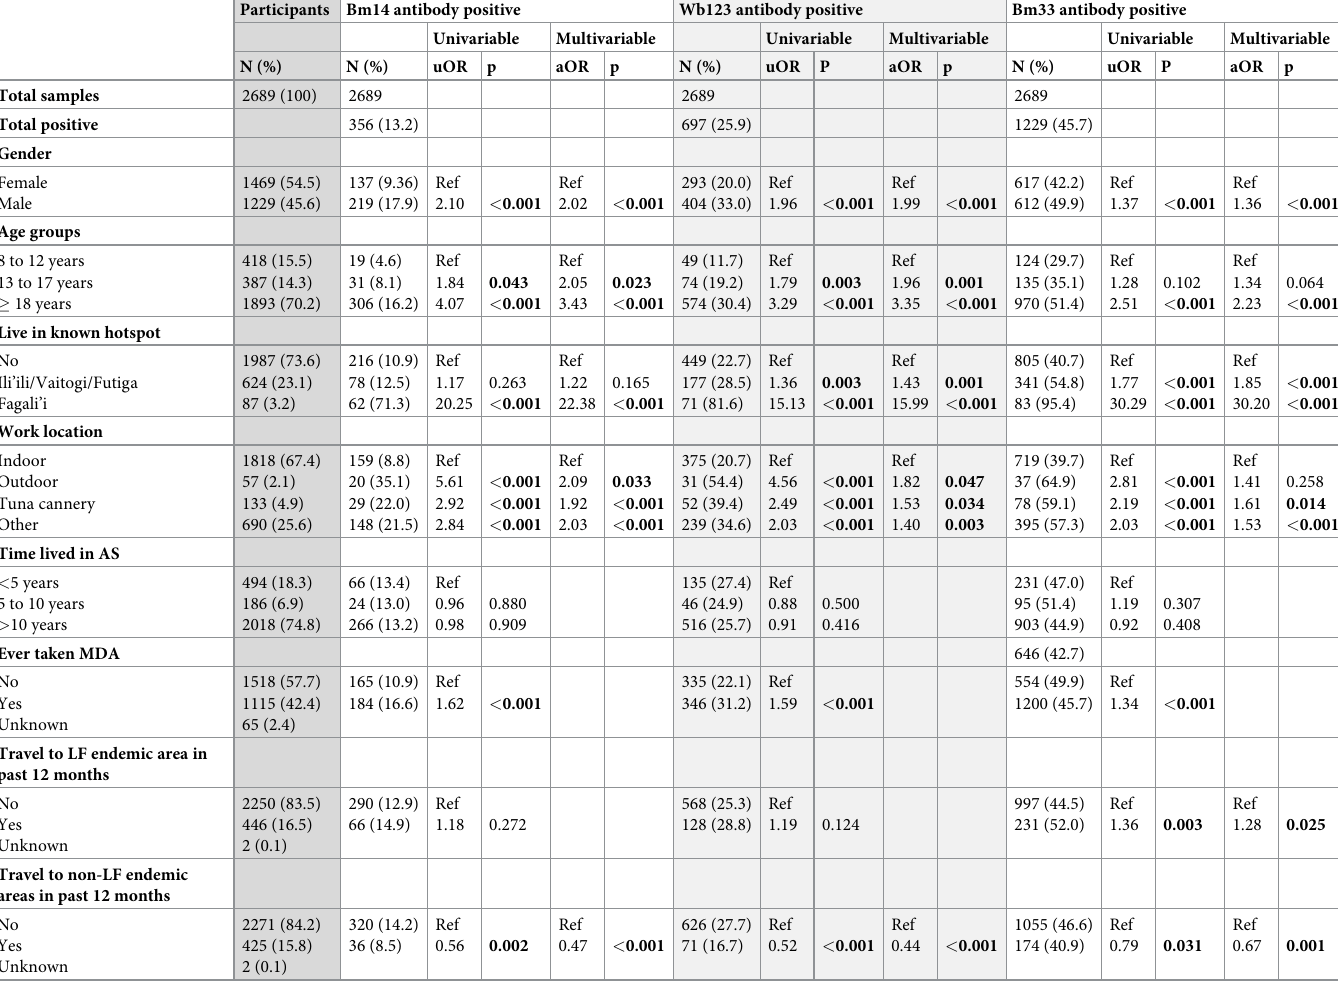
Table 2. Community survey of residents aged � 8 years: Summary of demographic and behavioural factors, and their associations with positive Bm14, Wb123, and Bm33 antibodies on univariable and multivariable logistic